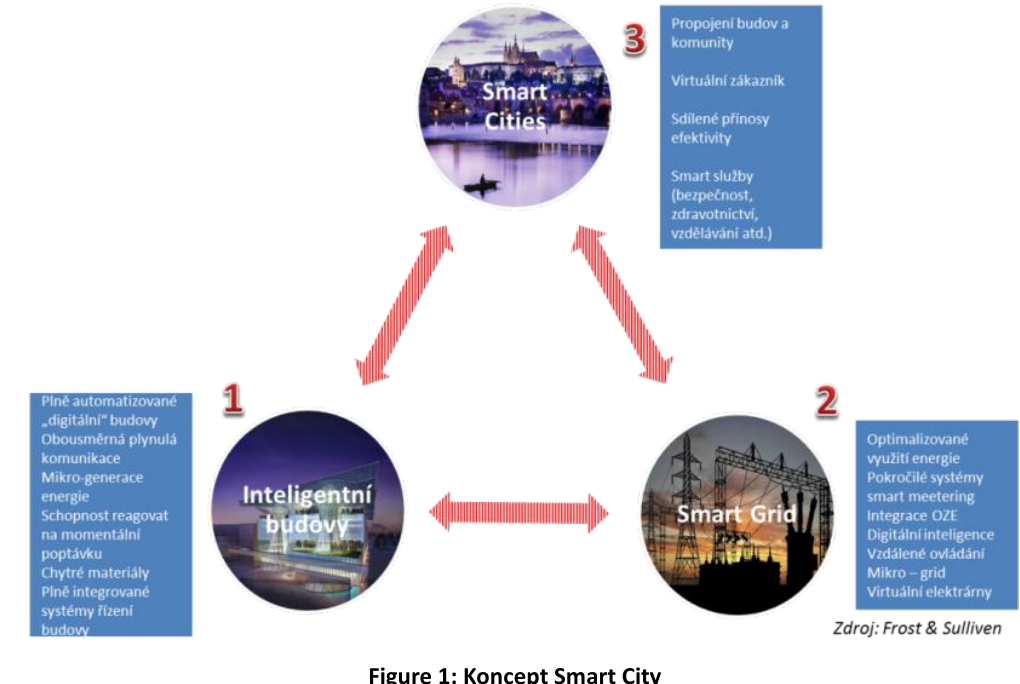
Figure 1: Koncept Smart